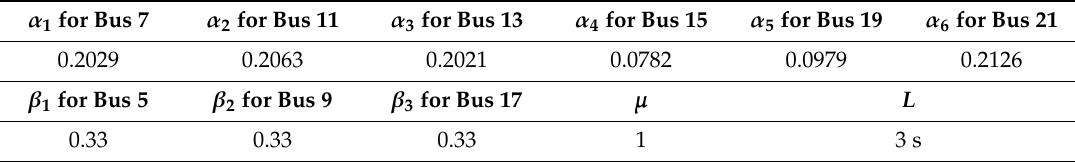
Table 1. Key parameters of the simulation